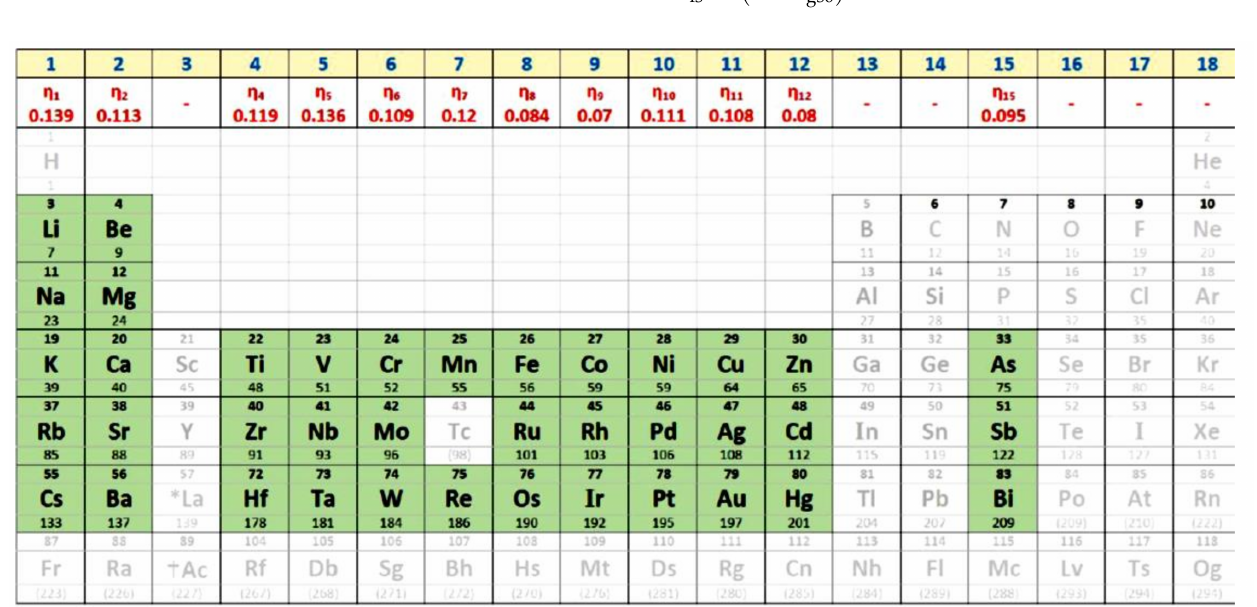
Figure 1. Lindemann coefficients of liquid elements distributed along columns of periodic table of elements by Mendeleev. The Lindemann coefficients δ ls along Line 2 for each column. Reprinted with permission from [77]. Copyright 2019